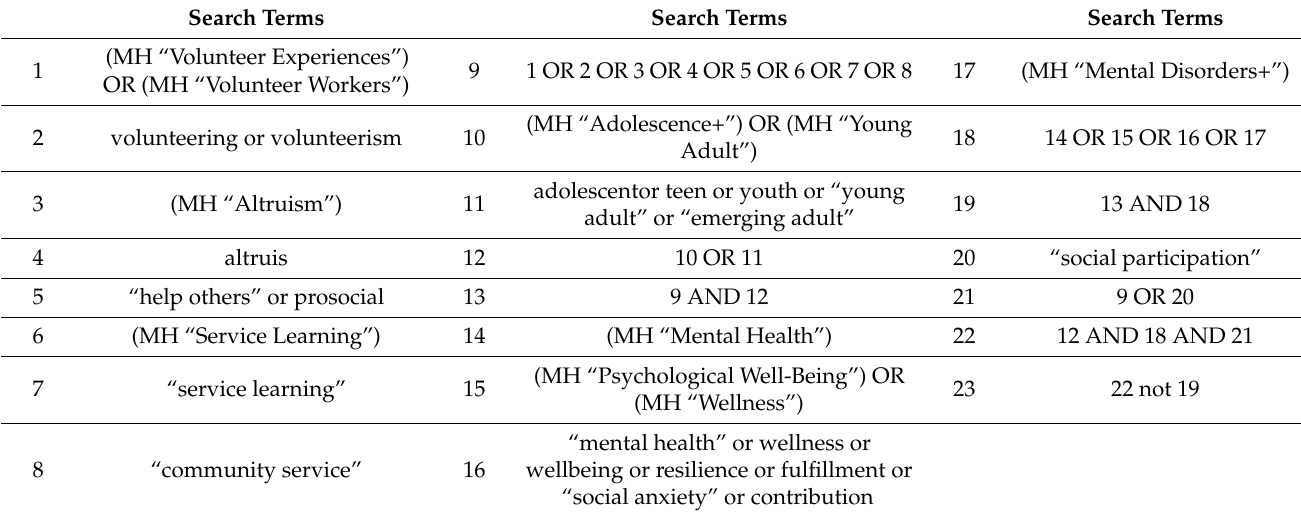
Table 1. Terms Used in the Literature